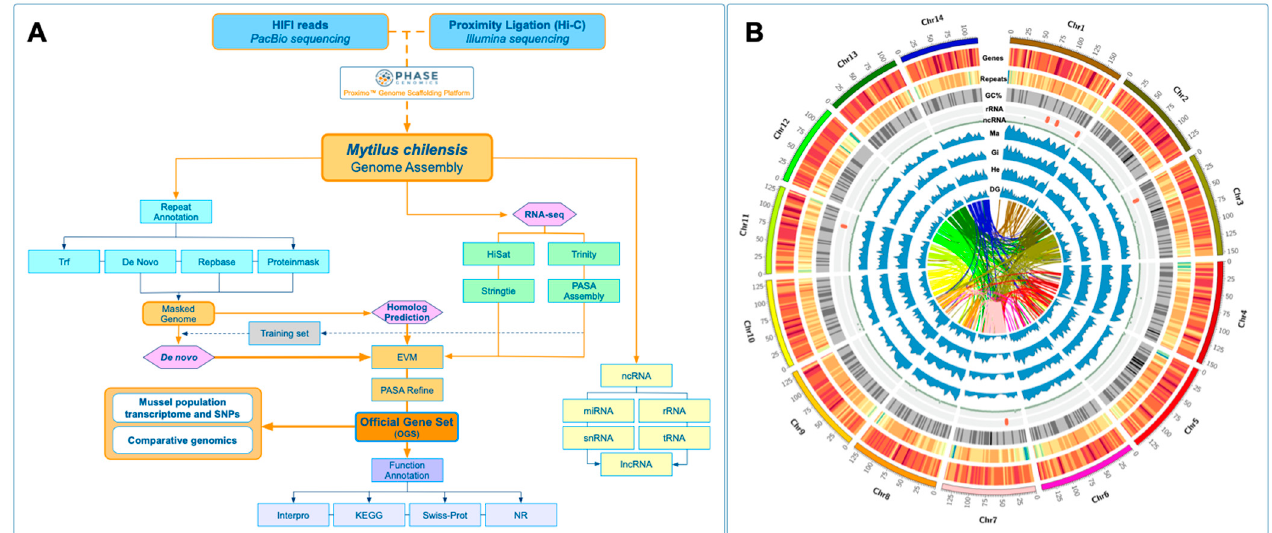
Figure 2. The native blue mussel Mytilus chilensis genome. ( A ) Workflow of de novo whole-genome sequencing project and annotation for M. chilensis . The rectangles indicate the steps of the primary data processing, and the arrows indicate output or input data. Pink diamonds indicate the combined strategy based on homolog prediction, de novo, and RNA-seq-assisted prediction. ( B ) The Circos plot shows the genomic features for the 14 pseudo-chromosomes. From the outer to the inner circle: gene density, repeat density, GC content, rRNA localization, and ncRNAs. The transcriptome expression for mantle (Ma), gills (Gi), hemocytes (He), and digestive gland (DG) are shown as light blue profiles. Chromosome syntenies are represented in different colors according to each ideogram. The chromosome size is shown in the Mb